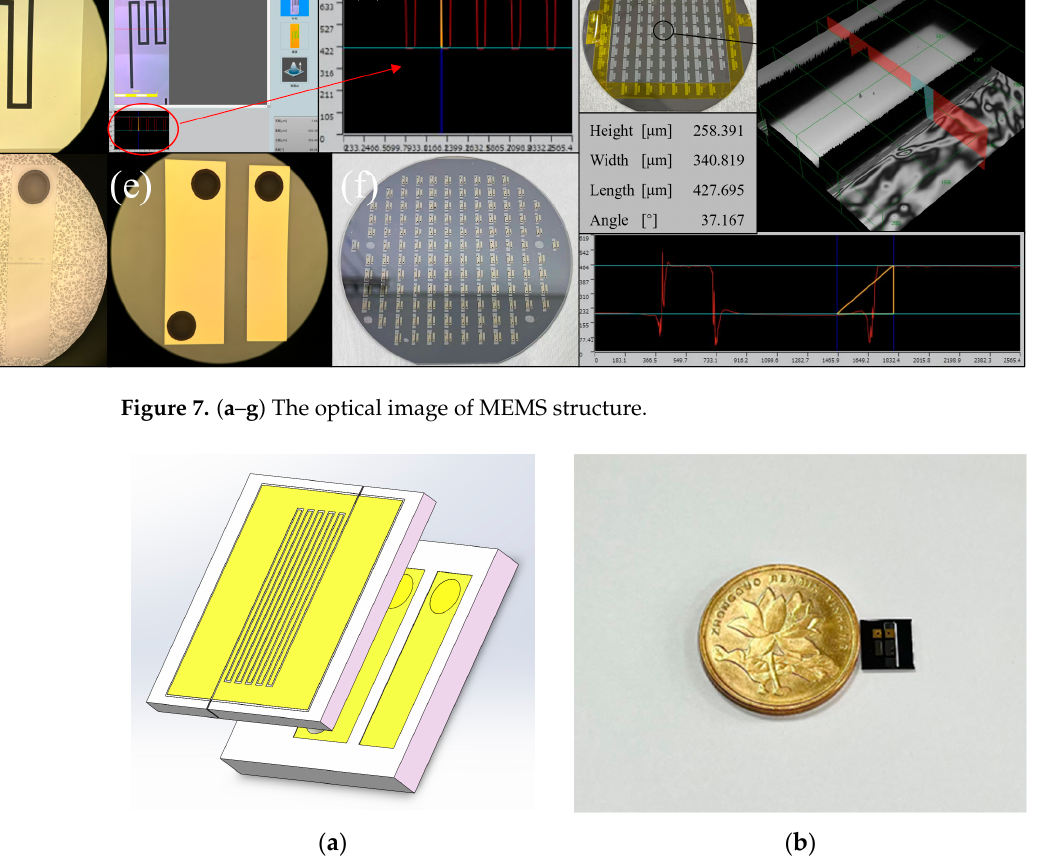
Figure 8. ( a ) Schematic diagram of the 3D structure of the sensor chip; ( b ) comparison of sensor chip and coin size.